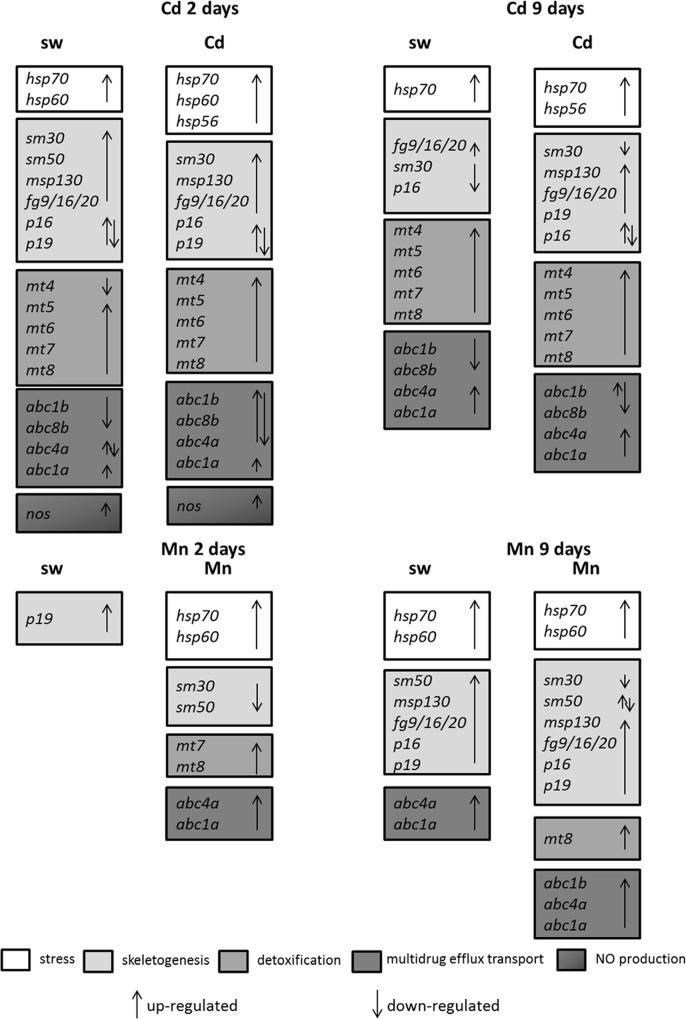
Synopsis of the patterns of up- and down-regulation of different classes of genes in the offspring of P. lividus females exposed to cadmium (Cd) or manganese (Mn) for 2 and 9 days.The two arrows indicate the up- or down-regulation of genes in different developmental stages.